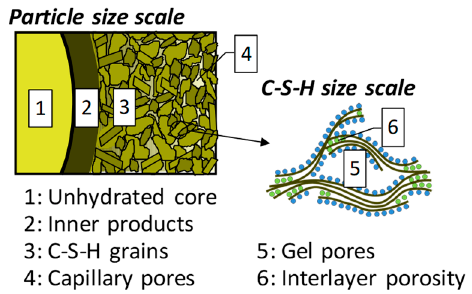
Figure 20. Schematic view of fine micro-pore structure resulting from dense precipitation of hydration products in open spaces.